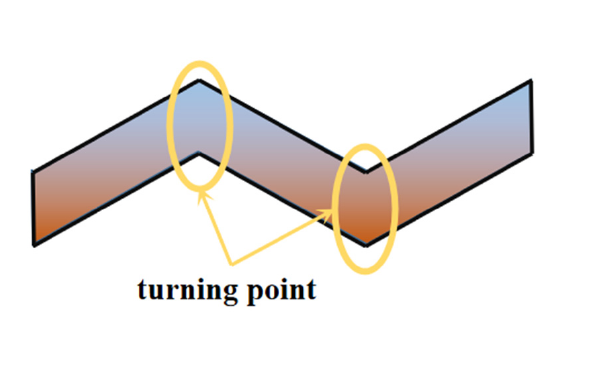
Figure 11. Turning point and stagnant region: ( a ) Turning point; ( b ) Stagnant region.